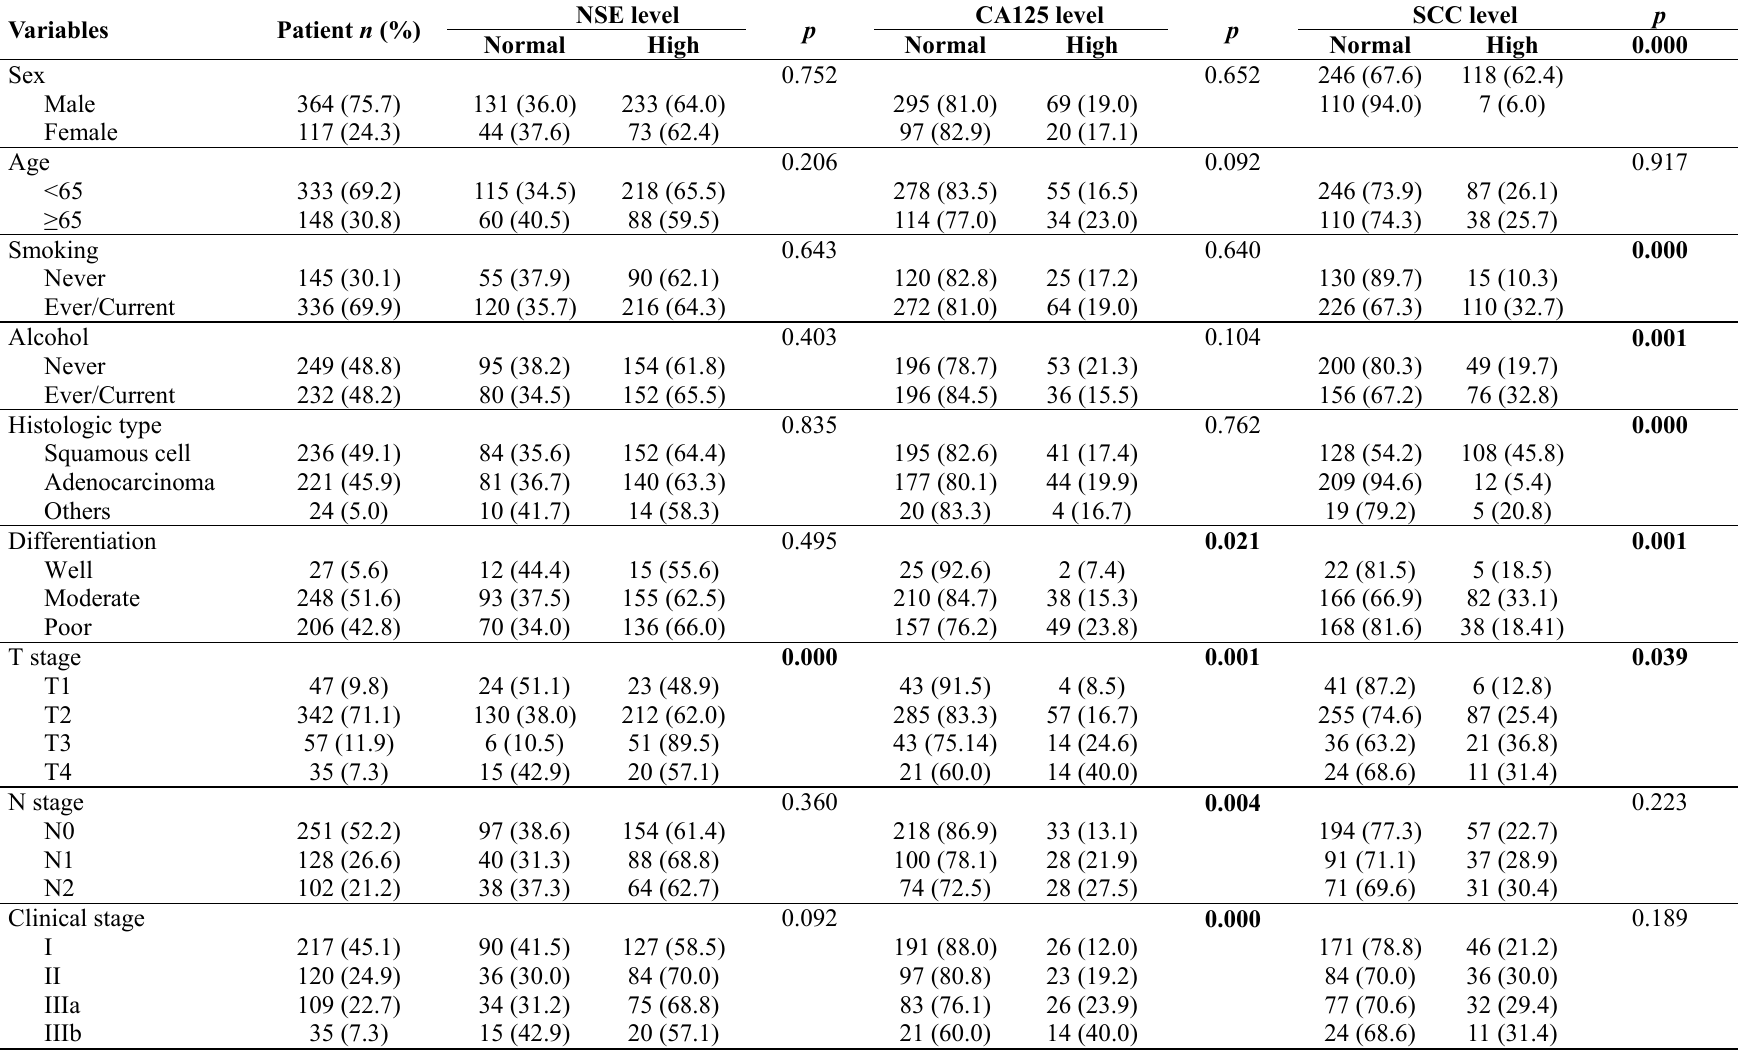
Table 1. Association of tumor marker with parameters of patients with non-small cell lung cancer